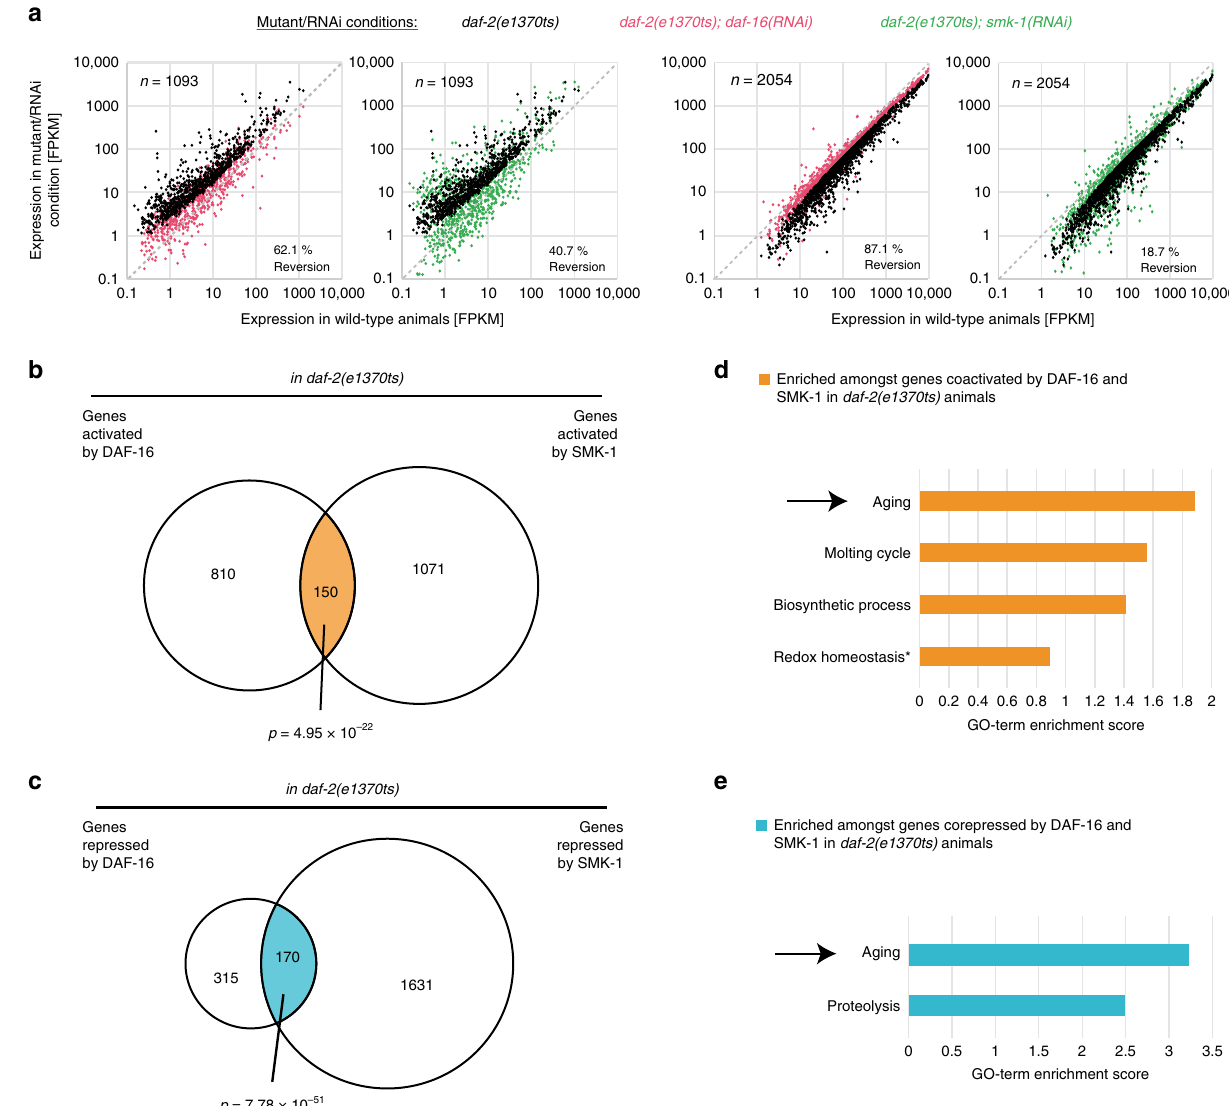
Fig. 4 PP4 SMK-1 is required for a substantial part of the DAF-16-mediated gene expression changes induced by low IIS. daf-2(e1370ts) mutant C. elegans were grown from the L1 stage on either control, daf-16 , or smk-1 RNAi bacteria. At the L4 stage, animals were shifted for 16 h to 25 °C, then harvested, and their transcriptomes determined by mRNA-seq. All strains used in in this fi gure harbored the eri-1(mg366ts) mutation to yield better knockdown ef fi ciencies 51 . a Similar to daf-16 loss, smk-1 loss also suppresses many of the gene expression changes that occur under low IIS. The scatter plots on the left show the genes signi fi cantly upregulated and the scatter plots on the right show the genes signi fi cantly downregulated in daf-2(e1370ts) compared with wild type animals. b , c Venn diagrams illustrate the number of genes signi fi cantly regulated by DAF-16 or SMK-1 in daf-2(e1370ts) mutant animals as well as their overlap. d , e Functional enrichment analyses, conducted on the co-activated and co-repressed genes shown in b and c . Only signi fi cant enrichments are shown (DAVID scores ≥ 1.3, the symbol asterisk indicates that this term was still amongst the four most enriched GO-terms and relevant in the context of aging and stress responses, but it had a score below the signi fi cance threshold). Arrows highlight the GO-term “ aging ” , which turned out to be the most enriched in both